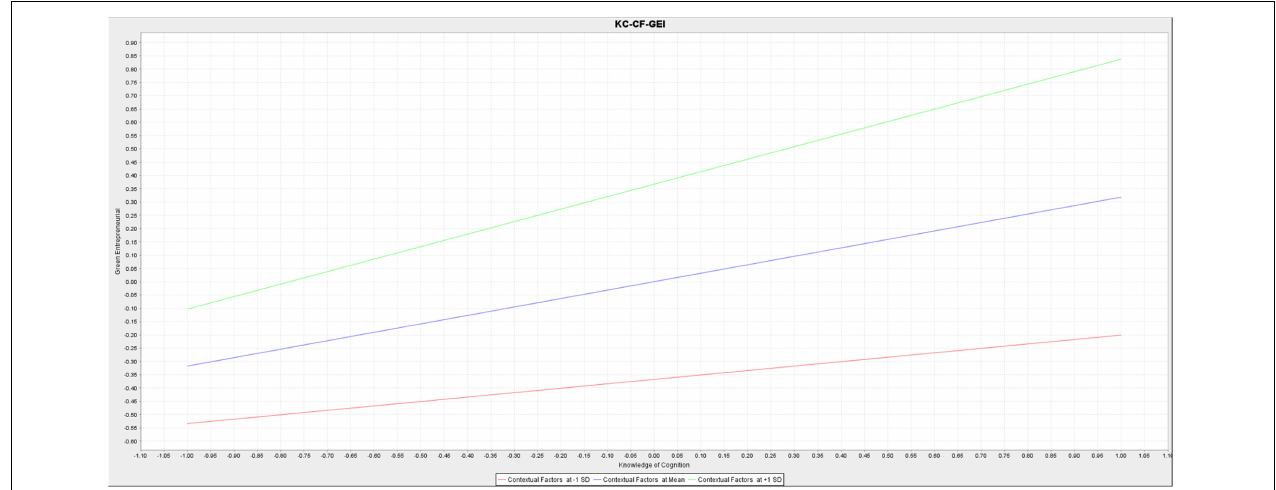
FIGURE 5 | The simple slope for the moderating effect of contextual factors on the relationship between knowledge of cognition and entrepreneurial intentions.